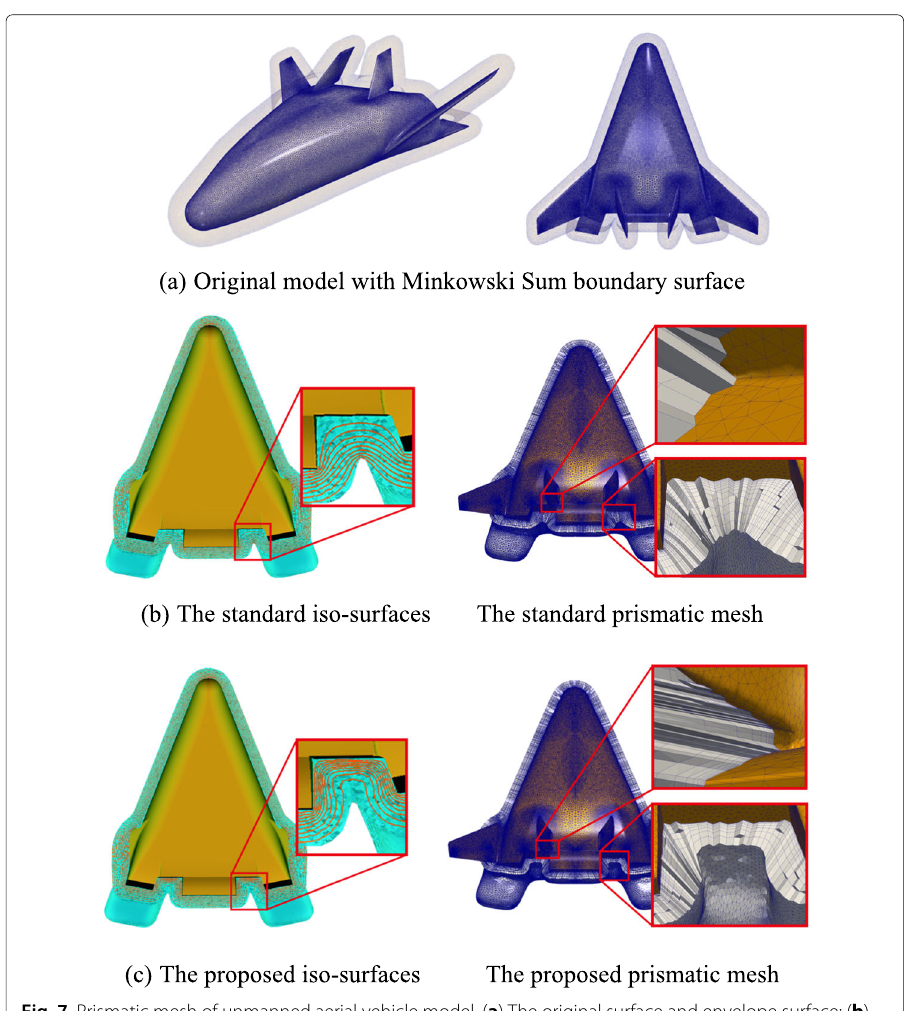
Fig. 7 Prismatic mesh of unmanned aerial vehicle model. ( a ) The original surface and envelope surface; ( b ) and ( c ) The iso-surfaces and prismatic meshes generated using the standard harmonic field and the proposed anisotropic harmonic field,